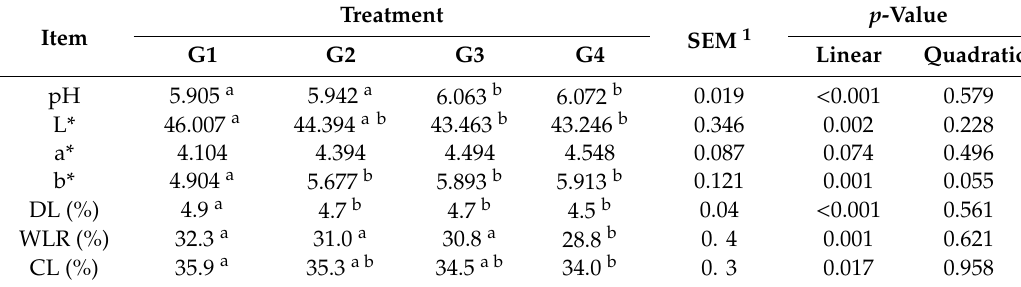
a,b : Values in rows with di ff erent letters di ff er significantly ( p < 0.05). 1 SEM: standard error of the mean. Broilers in the G1, G2, G3, and G4 groups were housed in the hot environment and fed the basal diet with 0, 0.5%,